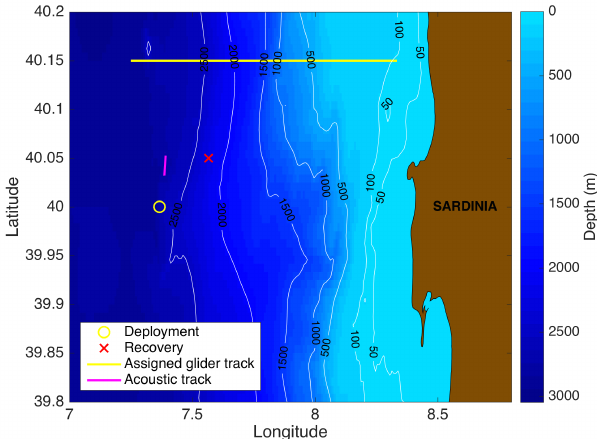
Figure 2. Bathymetry off the west coast of the island of Sardinia, Italy, showing the glider’s deployment (yellow circle) and recov- ery (red cross) locations, as well as the glider’s pre-assigned track for the experiment, and the glider trajectory (vertical magenta line) during the recording of file 06, used in this work. Due to a failure in hardware, the glider never made it to its assigned track. Note that the glider flew for approximately 1 day from the deployment day, but was recovered 3 days later, having drifted east from its original trajectory due